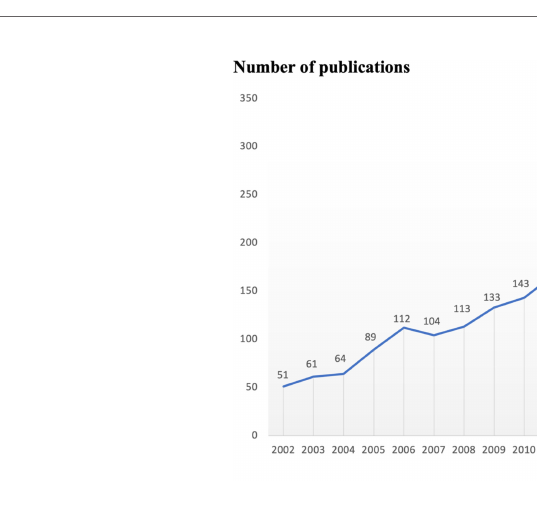
TABLE 1 | The top 10 journals of osteoblasts-osteoclasts in bone disease research. Rank